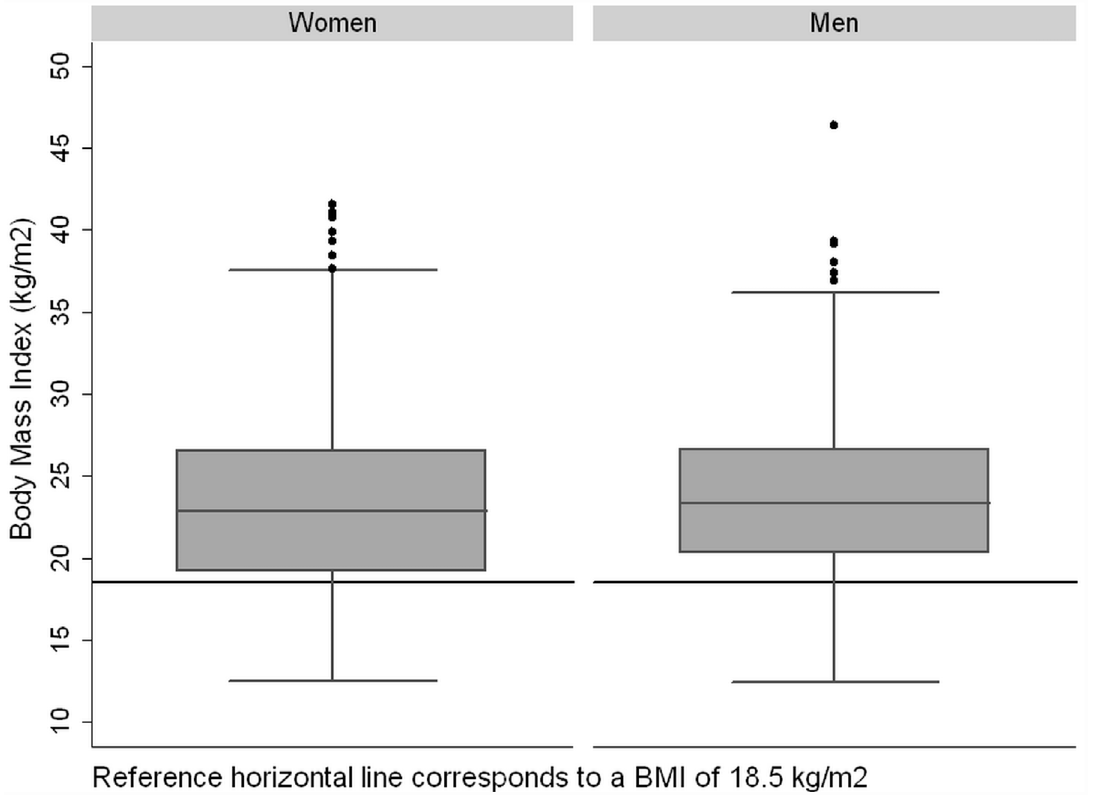
Fig 1. Box plot of Body Mass Index (kg/m 2 ) in women and